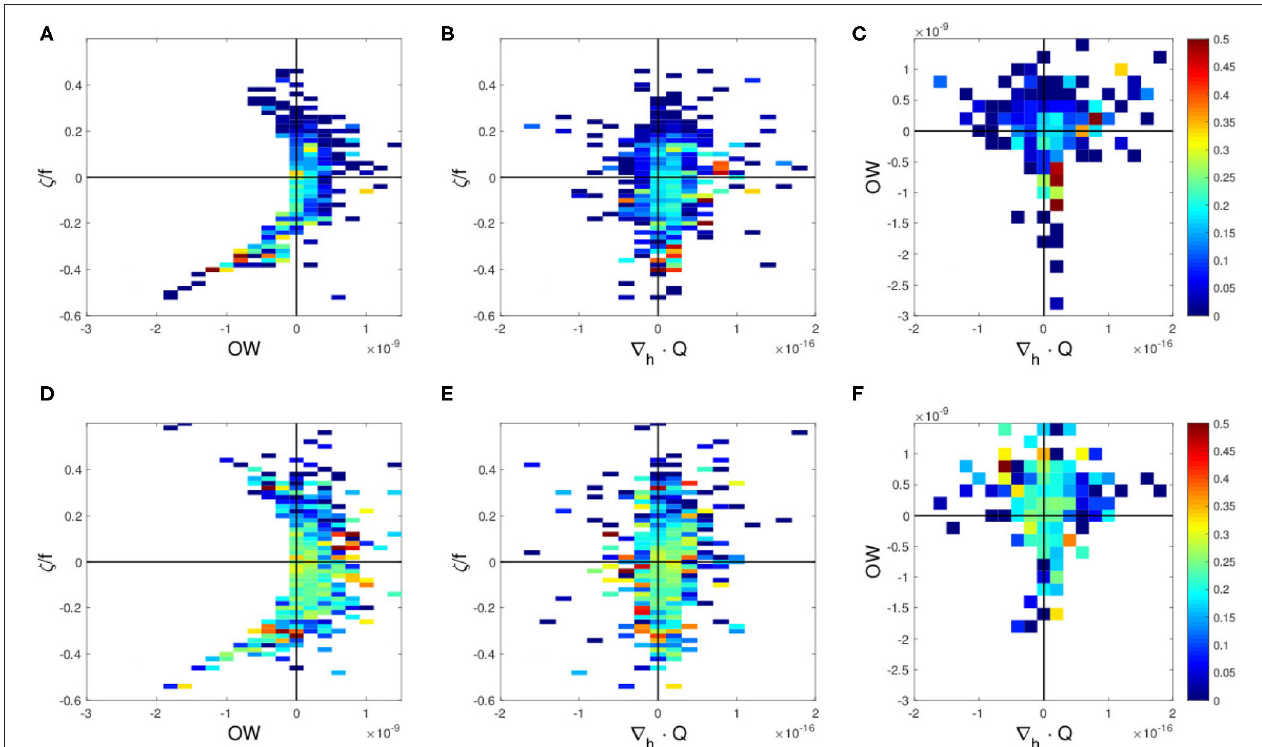
FIGURE 6 | Swordfish CPUE during the stable years 2004–2005 and 2010 as a function of (A,D) Okubo-Weiss (OW) parameter (2) and vorticity (3) normalized by f Coriolis parameter, ζ/ f , (B,E) divergence of Q-vector, ∇ h · Q (4) and normalized vorticity ζ/ f , and (C,F) divergence of Q-vector and OW for (A–C) the northern region